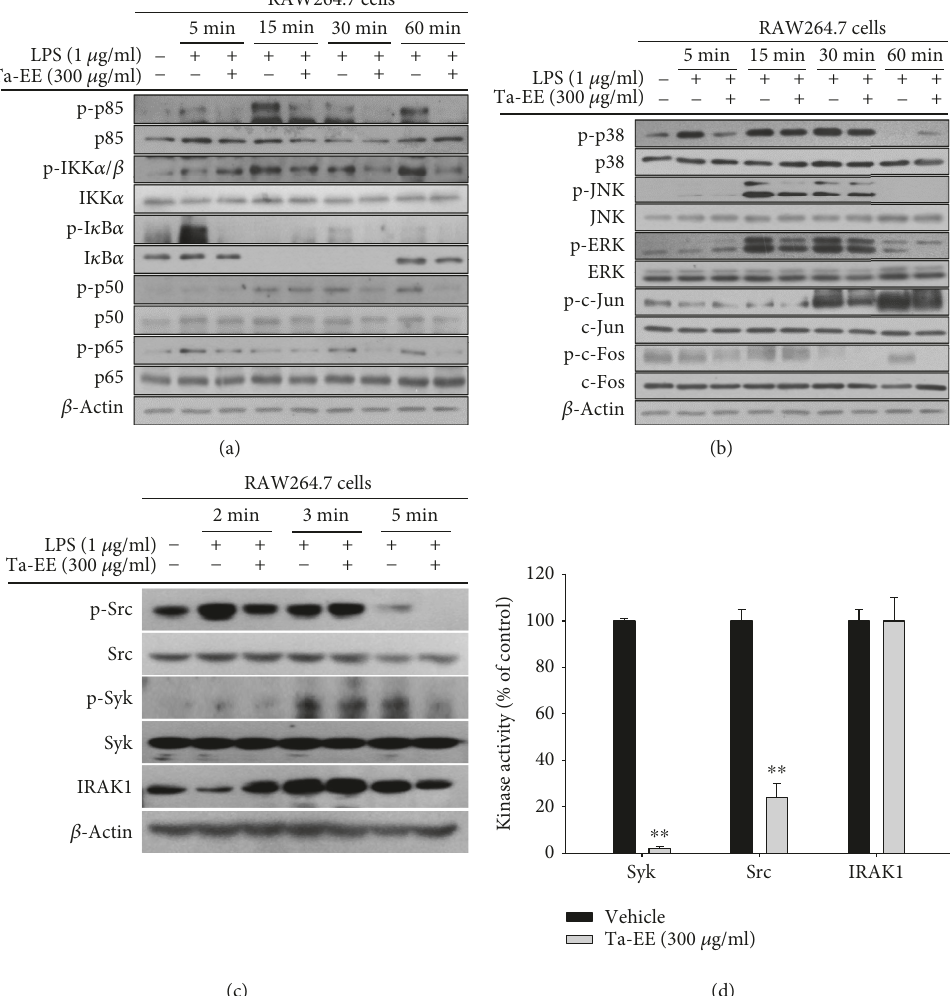
Figure 4: Ta-EE suppressed the activation of the NF- κ B and AP-1 signaling pathways in LPS-stimulated RAW264.7 cells. RAW264.7 cells pretreated with Ta-EE (300 μ g/ml) for 30 min were treated with LPS (1 μ g/ml) for the indicated time, and the total and phosphorylated protein levels of (a) p85, IKK α / β , I κ B α , p50, and p65; (b) p38, JNK, ERK, c-Jun, and c-Fos; and (c) Src, Syk, and IRAK1 in the total cell lysates were determined by Western blot analysis. β -Actin was used as an internal control. (d) E ff ects of Ta-EE on the kinase activities of Src, Syk, and IRAK1 were determined by in vitro kinase assay using puri fi ed Src, Syk, and IRAK1 as described in Materials and Methods. ∗ P < 0 05 and ∗∗ P < 0 005 versus a control